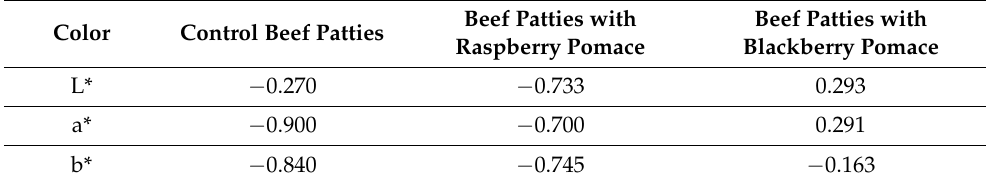
Table 4. Correlation coefficient between beef patties color parameters and